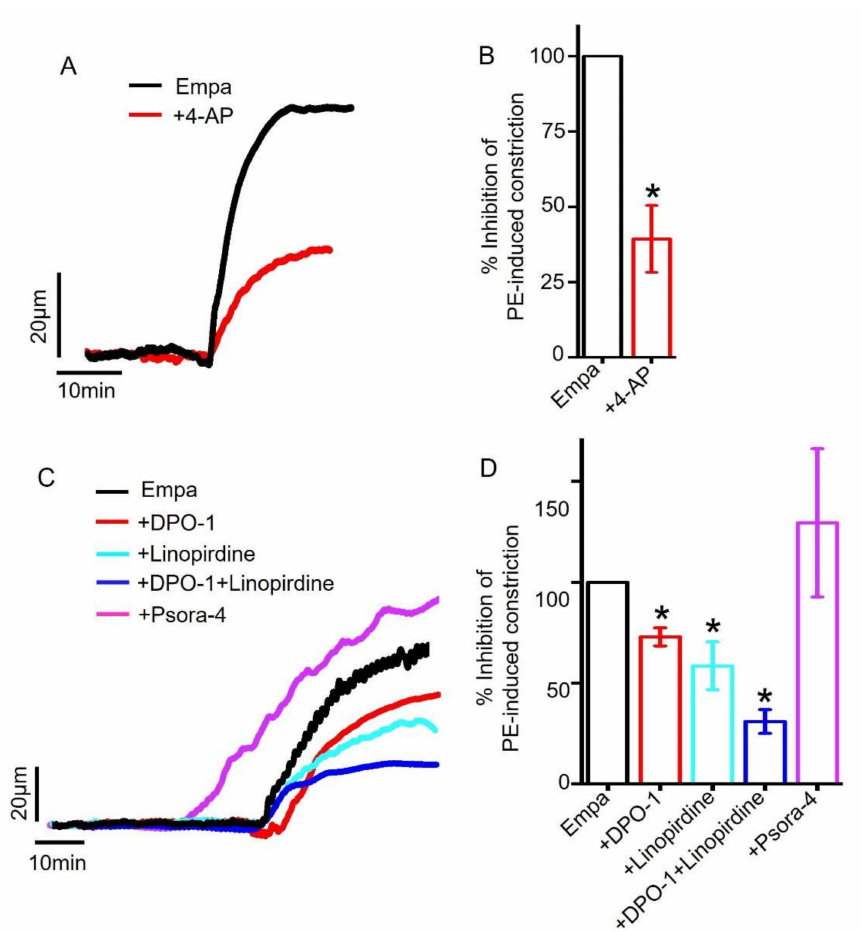
Figure 6. Role of smooth muscle cell K V channels in empagliflozin-induced vasodilation. ( A ) Original traces showing that non-selective inhibition of K V channels with 4-AP (1 mM) reduced Empa-induced vasodilation in mesenteric arteries. ( B ) Mean data illustrating significant reduction in Empa-evoked vasodilation by non-selective inhibition of K V channels, n = 4. * p < 0.05 vs. Empa. ( C ) Original traces illustrating the effects of K V 1.5, K V 7 and K V 1.3 channel inhibitors (1 µ M DPO-1, 10 µ M linopirdine and 100 nM psora-4, respectively) on Empa-induced vasodilation in resistance mesenteric arteries. ( D ) Mean data comparing the modulation of Empa-evoked vasodilation by KV1.5, KV7 and KV1.3 channel inhibition, n = 3–7. * p < 0.05 vs.